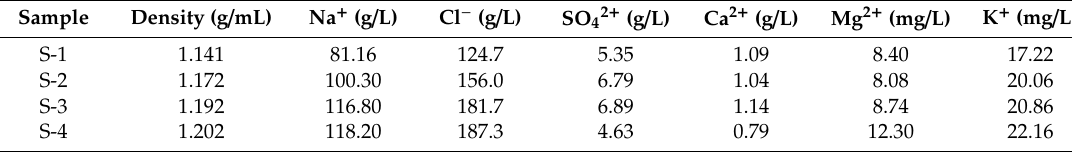
Table 2. Component analysis of brine samples of Jintan salt mine.